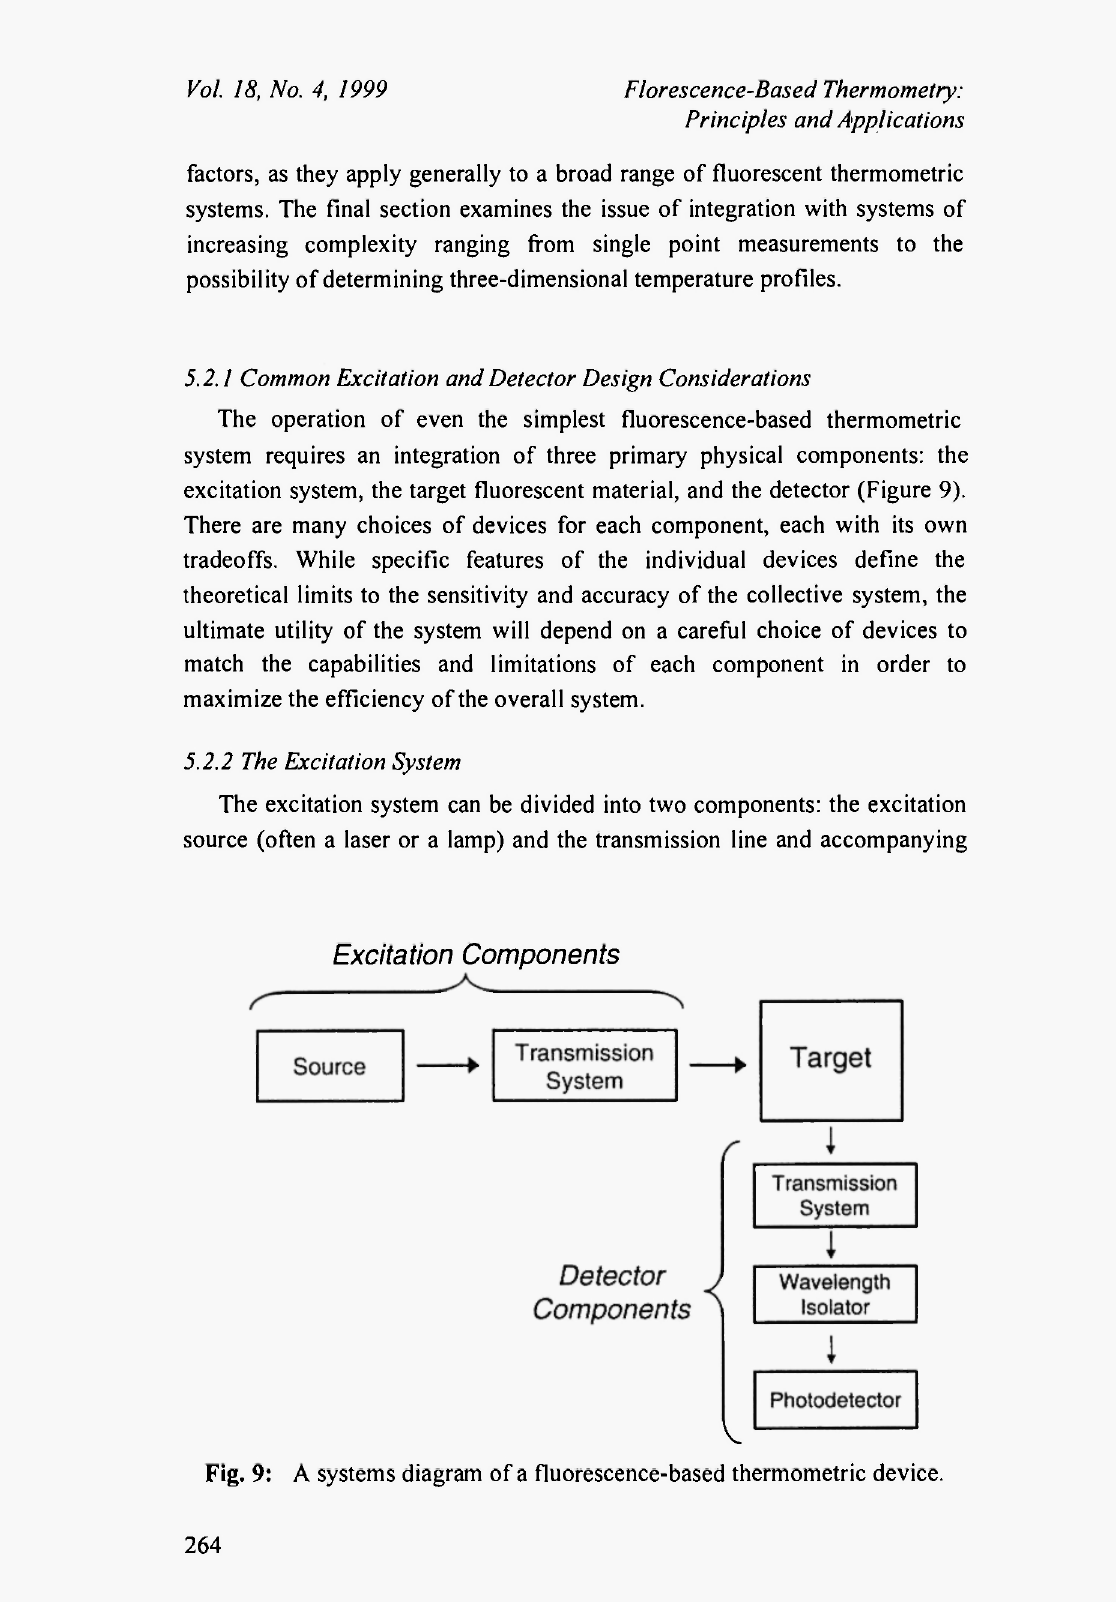
Fig. 9: A systems diagram of a fluorescence-based thermometric device.